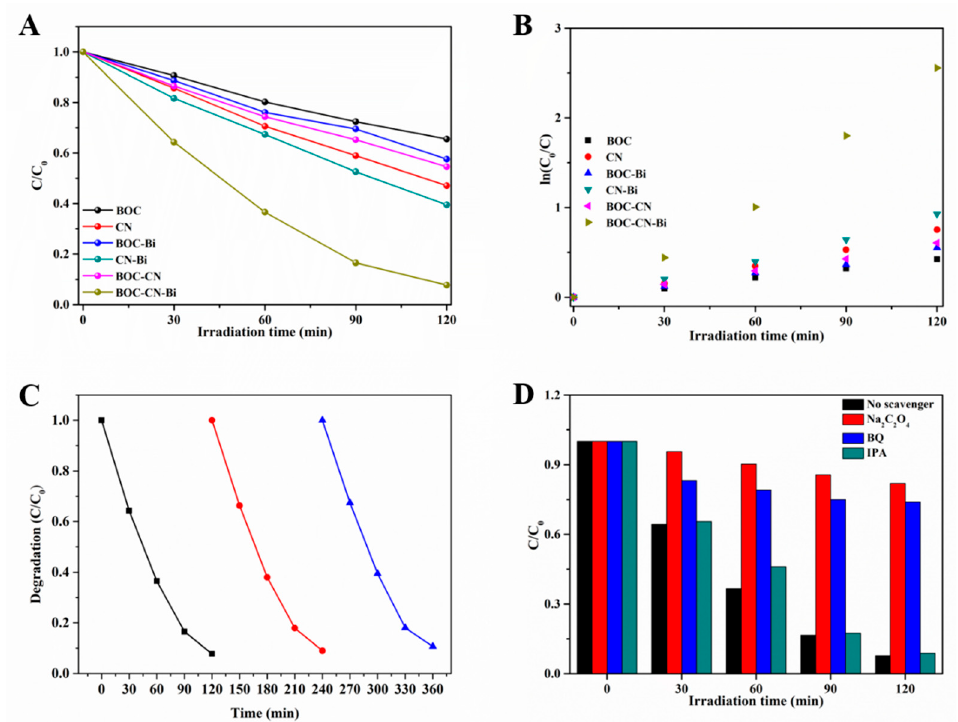
Figure 6. The photodegradation of different organic pollutants ( A ) and kinetics of the RhB decomposition ( B ) over as-prepared samples, the cycling experiments ( C ) and the trapping experiment ( D ) the result of BOC-CN-Bi ternary composites by degrading RhB.